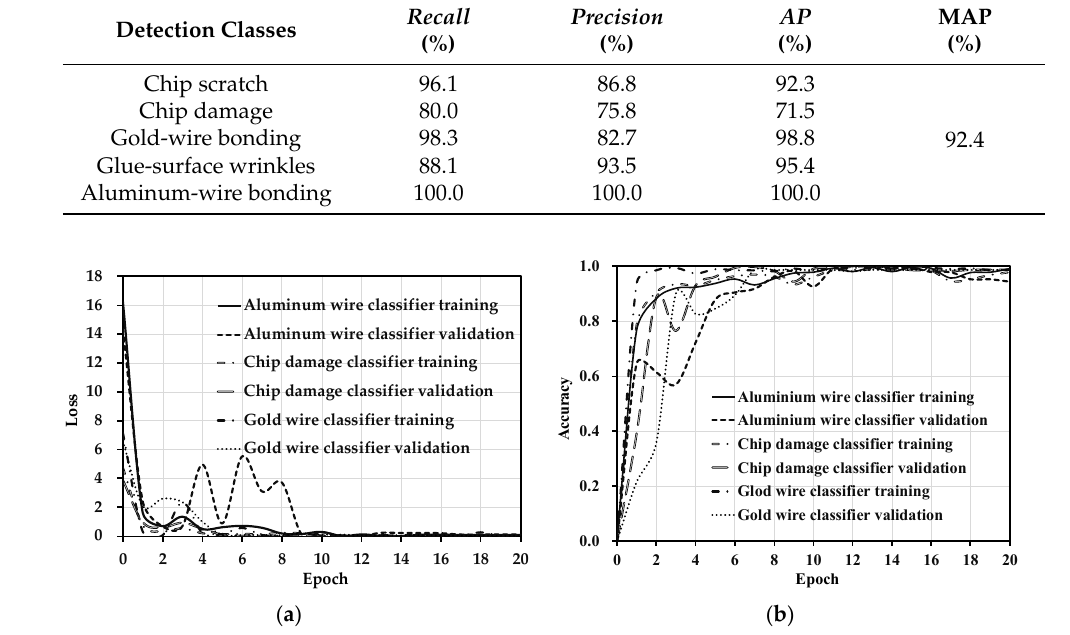
Table 2. Statistics of target-detection results with network optimization.